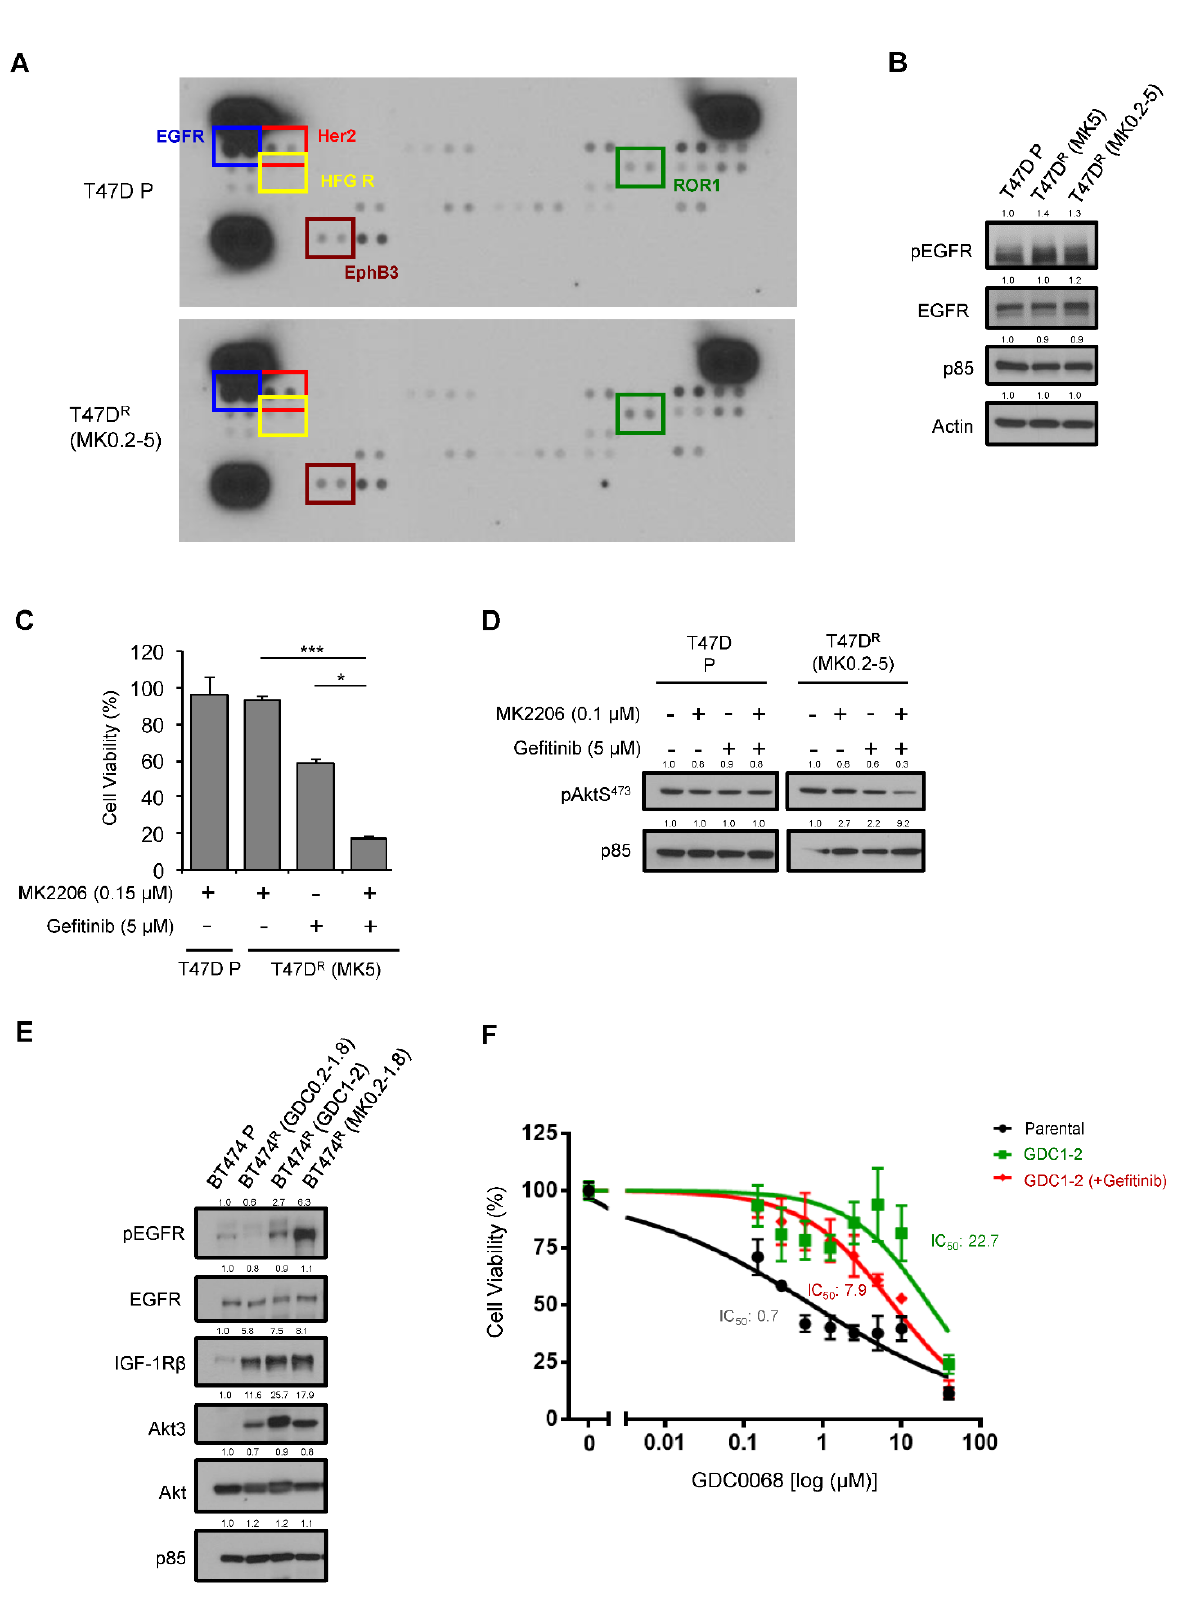
Figure 2. Upregulation of RTKs in Akt-inhibitor-resistant breast tumor cells. ( A ) Phospho-RTK arrays performed on lysates from T47D parental and resistant cells. ( B ) Western blot analysis on lysates of T47D parental and resistant cells. ( C ) T47D parental or resistant cells were seeded to plates without MK2206 for 24 h, followed by treatment with Gefitinib (5 µ M) and/or MK2206 (0.15 µ M) for 48